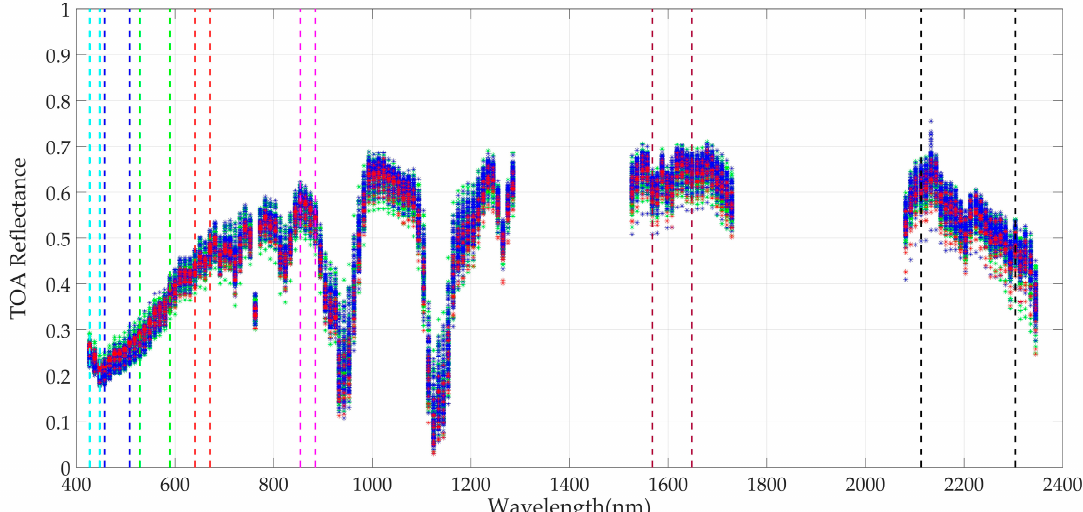
Figure 8. Hyperspectral data of cluster 13. Green represents the spectra from EO-1’s launch to 2007. Blue represents the spectra from 2008 through 2015 and red represent the spectral from 2016 to its decommissioning in March 2017. Highly absorption wavelength ranges are not displayed in the figure and vertical dashed lines represent typical wavelength ranges of Coastal, Blue, Green, Red, NIR, SWIR 1, and SWIR 2 bands used for remote sensing purposes.